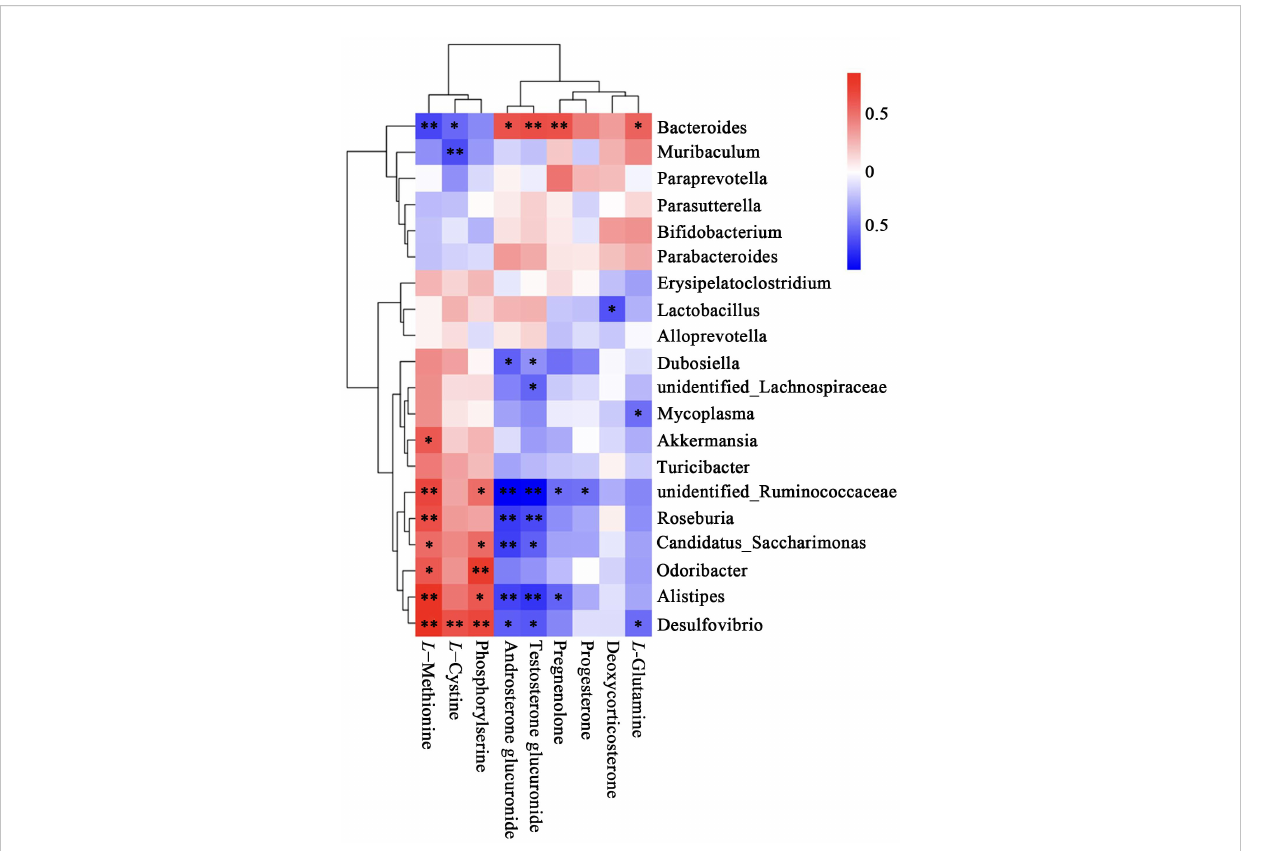
FIGURE 7 Heatmap of correlation between metabolites and top 20 relative abundance species at the genus level. The correlation (R) value is displayed in different colors in the fi gure. The legend on the right shows the range of colors for different R values, with red representing positive correlations and blue representing negative correlations. * P <0.05, ** P <